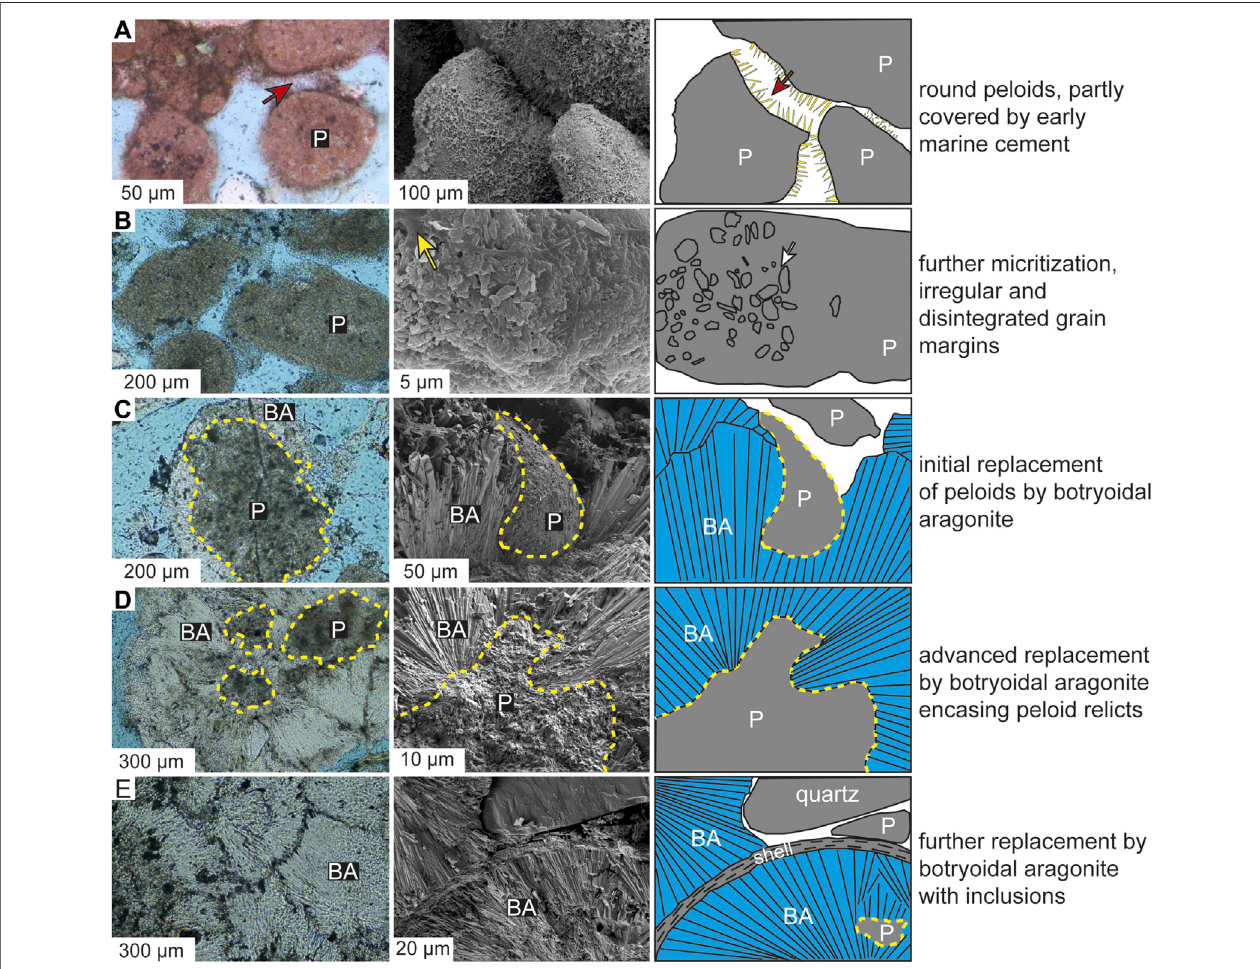
FIGURE 4 | Evolutionary steps from primary peloids at deposition (A) to botryoidal and spherulitic aragonite via early replacement (B) through (E) at Abu Dhabi showing thin section image (left) , SEM image (middle) and sketch (right) . BA-botryoidal aragonite; P- peloid. In (A) , the primary peloids with regular morphology are partly covered by early marine cements (red arrow). In (B) , part of the peloids shows disintegration into micritic crystals (white arrow) that are associated with bio fi lms (yellow arrow). In (C) , the peloids are partly replaced by botryoidal aragonite, showing irregular contact between both. In (D) , the peloids are further replaced by botryoidal aragonite, showing reduced size of peloidal part and increasing size of botryoidal part. In (E) , the peloids are almost totally replaced by botryoidal aragonite.